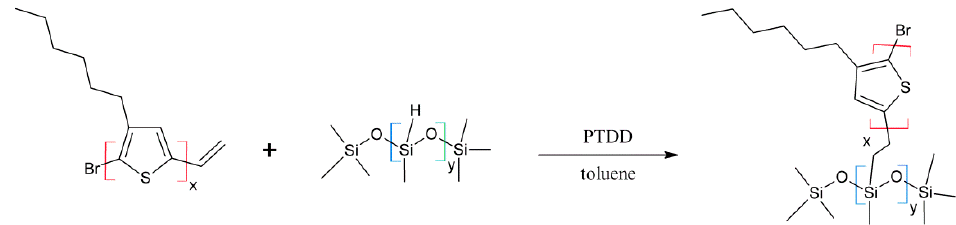
Scheme 2. Synthetic route to poly(methylhydrosiloxane)-graft-poly(3-hexylthiophene) (P3HT-Sil).